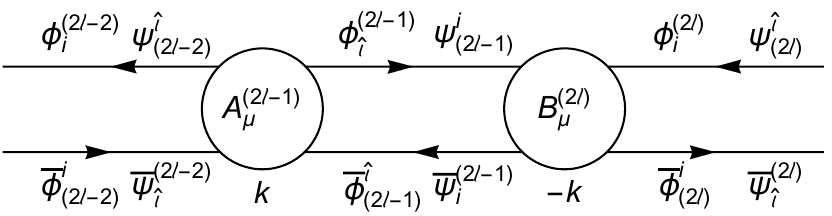
Figure 1 . A section of quiver diagram of the N = 4 circular quiver SCSM theories with alternating levels. We have ‘ = 1 ; 2 ; (cid:1) (cid:1) (cid:1) ; r